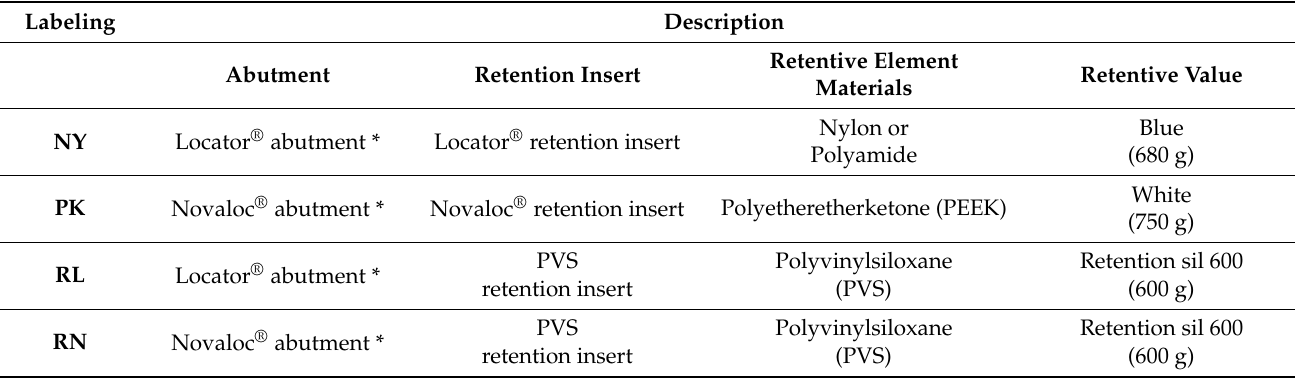
Table 1. Materials and labeling of tested attachment systems.